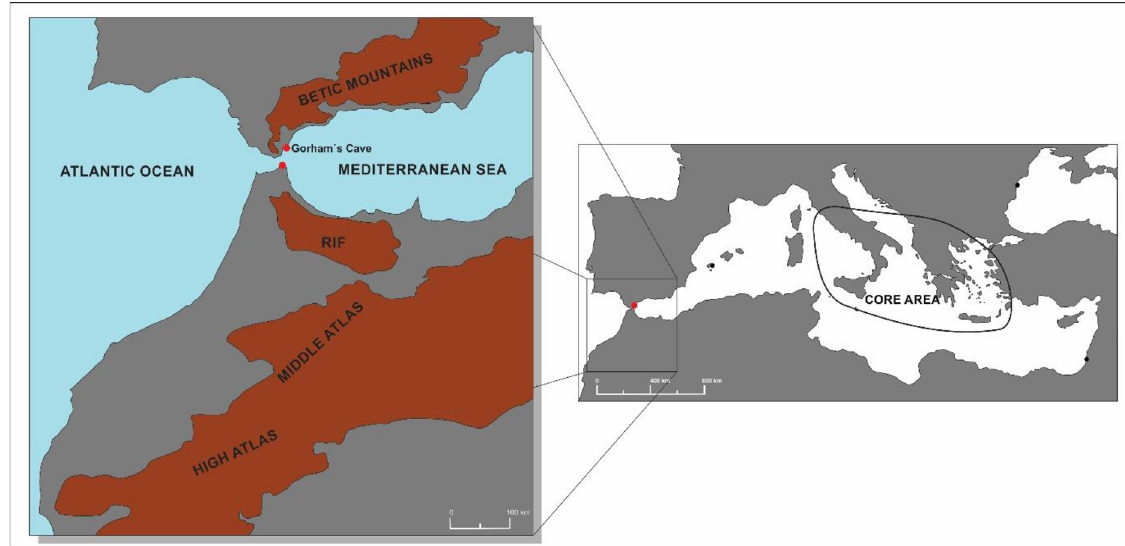
Fig 1. Map of the Mediterranean Sea showing the core area where Gorgoneia have been found. Exceptions outside the core area are in the Black Sea, Israel and Ibiza. The location of Gibraltar is indicated by a red dot. Details of individual sites are at S2 File. Inset shows the region of the Strait of Gibraltar, showing the location of Gorham’s Cave. The two Pillars of Herakles are marked by red dots, Gibraltar (Mons Calpe) being the northern Pillar. The location of the Atlas Mountains is indicated.